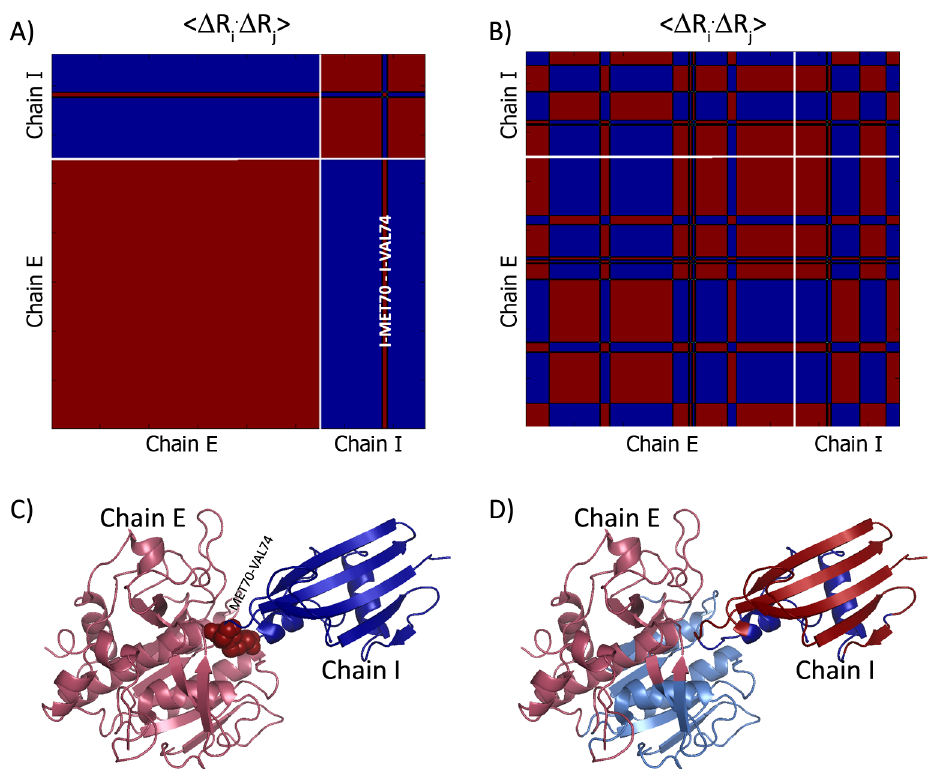
Fig 3. Dynamics of a non-obligatory complex. Slow modes of motion in the complex between subtilisin BPN ’ and proteinaceous inhibitor from Streptomyces (2SIC [52]). The upper panels show the matrices of correlations between residue fluctuations, h Δ R i (cid:4) Δ R j i , of mode 1 (A) and mode 2 (B) with negative and positive marked as blue and red, respectively. The boundaries between the subunits are marked in white. The lower panels show projection of the correlations on the 3D-structure: C- mode 1 and D- mode 2. The subunits are shown on the PyMOL [61] figures in lighter and darker versions of the same